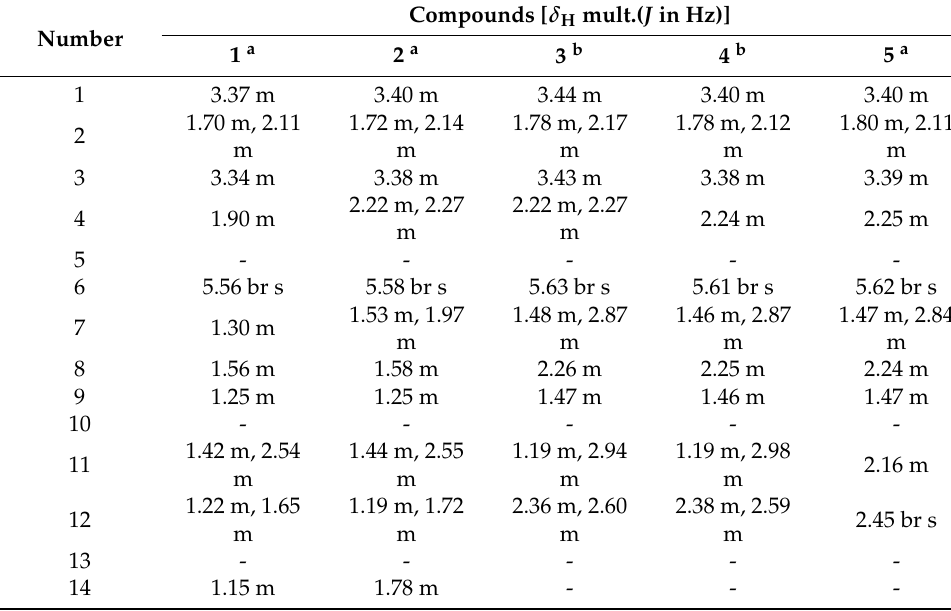
Table 2. 1 H-NMR data of aglycone moieties for compounds 1 – 5 in CD 3